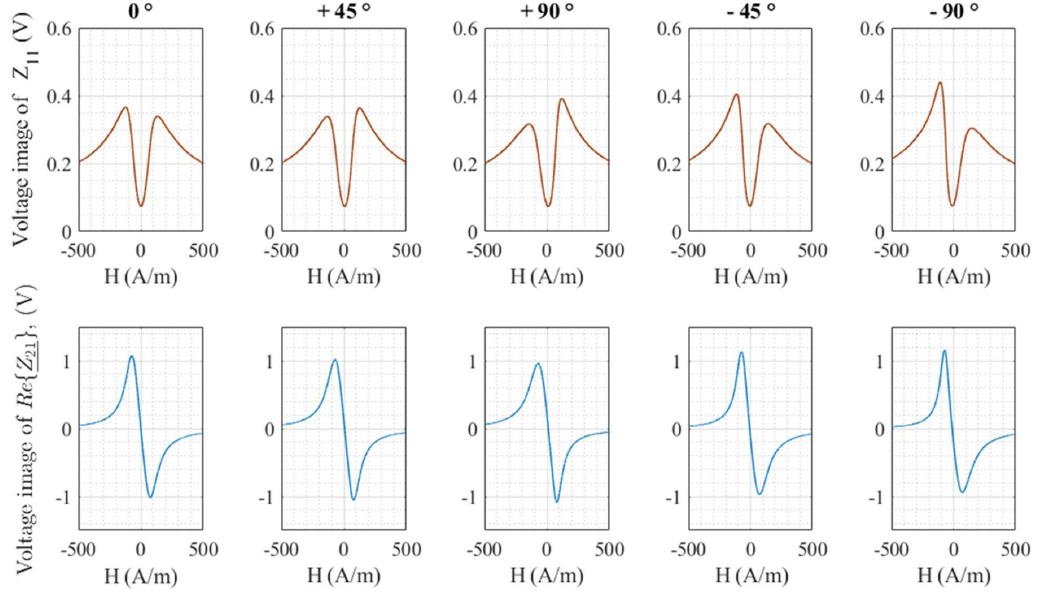
Figure 6. Voltages proportional to the diagonal and off-diagonal components as a function of the magnetic field for different rotation angles.